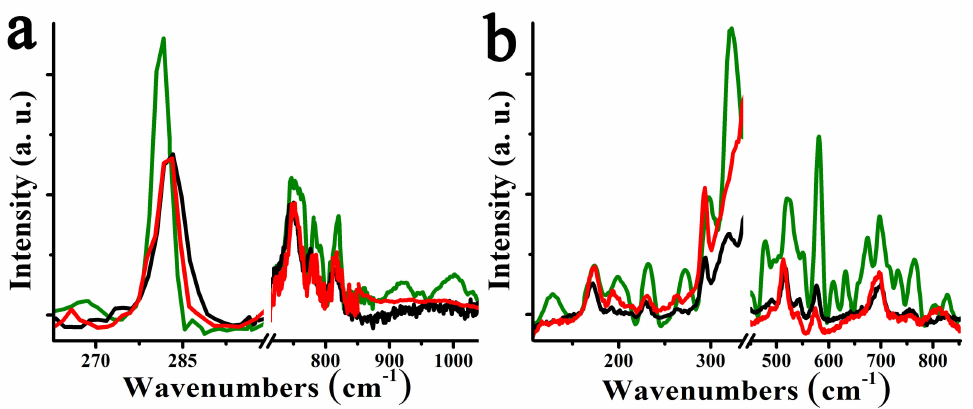
Figure 6. Raman spectra at 514 nm with 0.1 mW / 4 µ m 2 laser radiance, for ( a ) fresh exfoliated MoS 2 (black), aged exfoliated MoS 2 (green) and aged MoS 2 / pyrene 1a (red), and ( b ) fresh exfoliated WS 2 (black), aged exfoliated WS 2 (green) and aged WS 2 / pyrene 1b (red). The region showing the